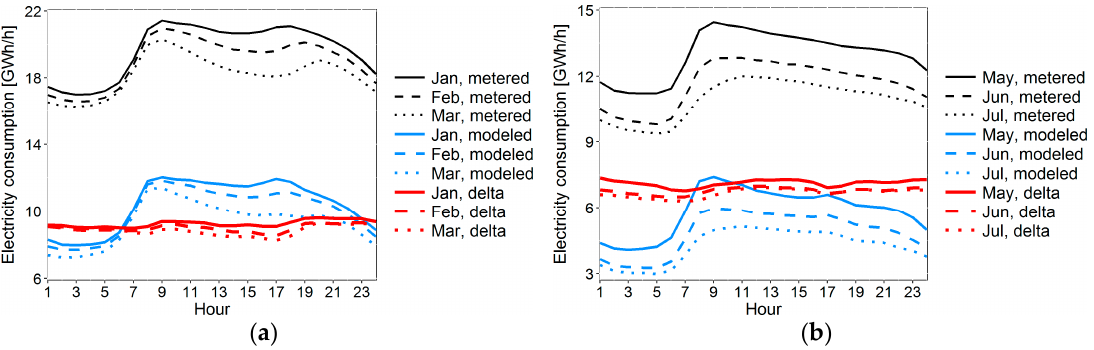
Figure 9. Average hourly electricity consumption in different months (workdays), 2013, metered (Nord Pool, NO [47]), modeled, and residual consumption delta: ( a ) January, February, March, ( b ) May, June, July.